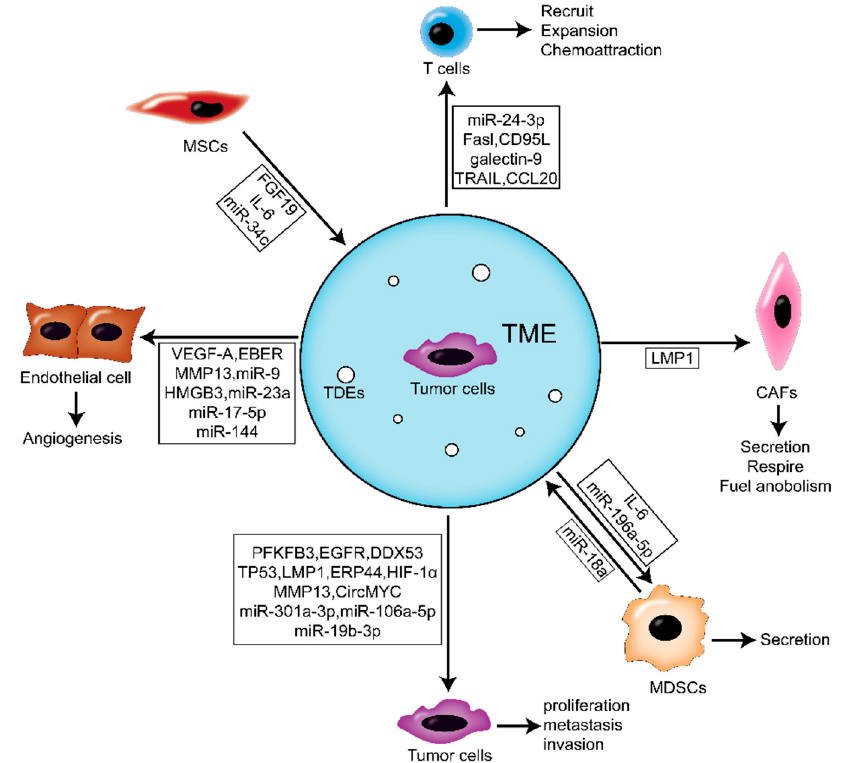
Figure 2. A schematic representation of the regulation of the EVs content from different sources on NPC cells and TME cells.